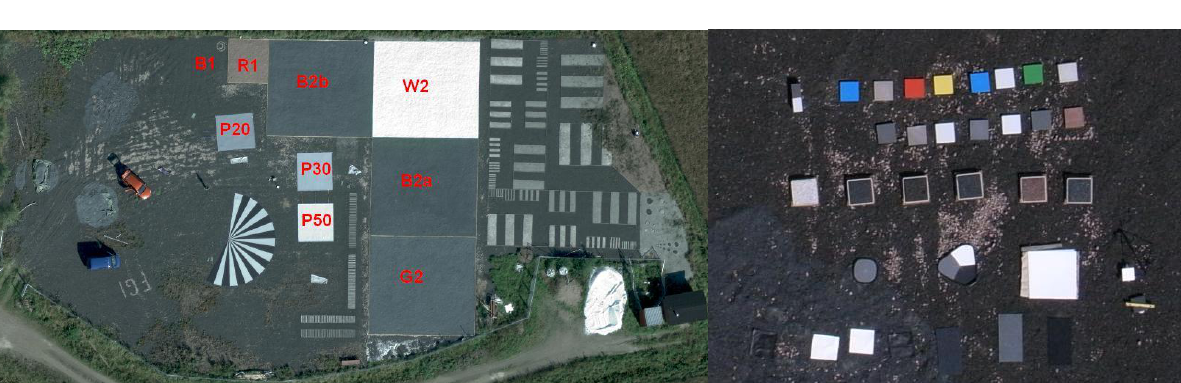
Figure 2. Left: Permanent Sjökulla image quality test field in September 2008 (with reference target indicators; P20, P30 and P40 are non-permanent targets). Right: Reference target samples at the test site in summer 2009. Colors and brightness are not calibrated or adjusted to the same scale.